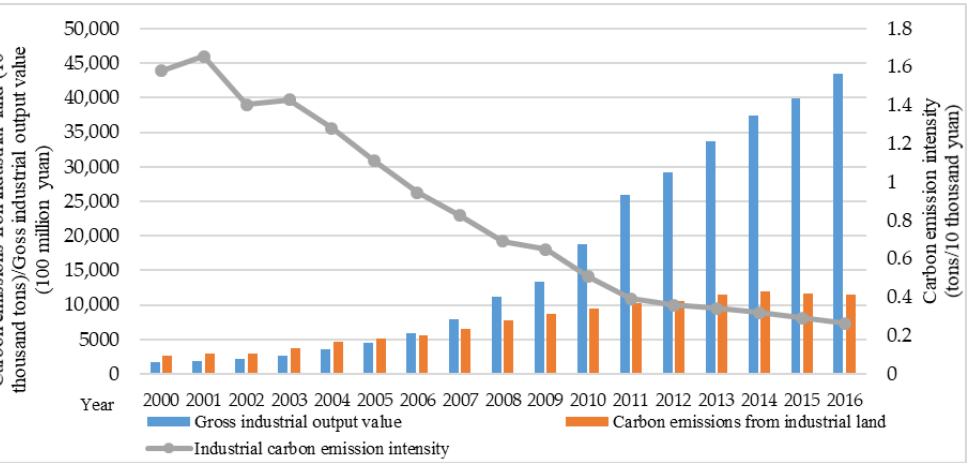
Figure 2. Changes in CEIL, GIOV, and ICEI in Anhui Province from 2000 to 2016.